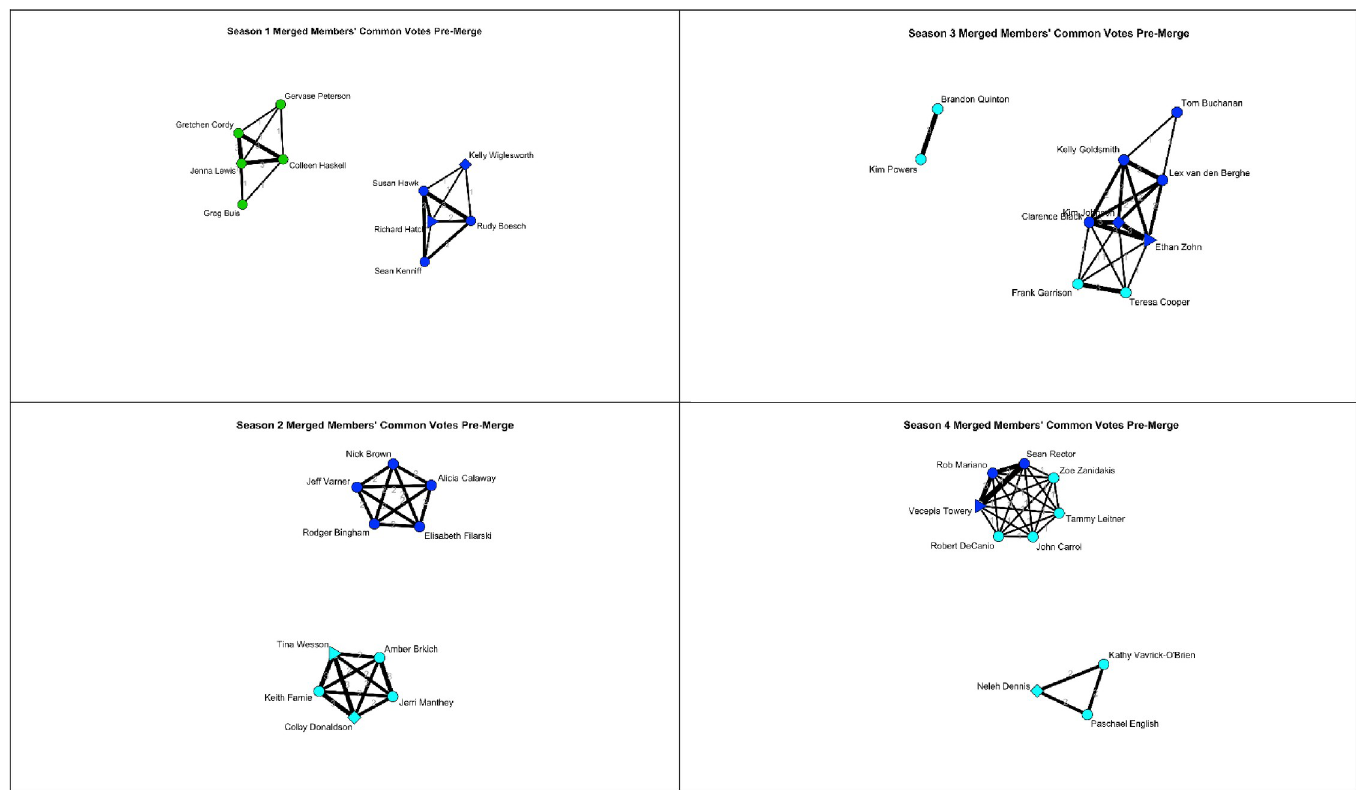
Fig 2. The role of social networks in